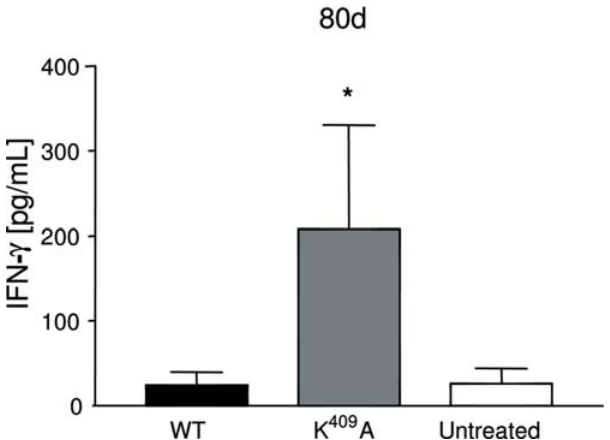
Figure 4. Enhanced interferon- c production in the serum of K 409 A treated [NZBxNZW]F 1 mice. IFN- c was measured in the serum of 80 days-old WT or K 409 A treated or untreated [NZBxNZW]F 1 mice [n=5–6/group] by ELISA. Untreated group has been the reference group for unpaired t -test analysis; * p , 0.05. Results are representative of 2 independent experiments.